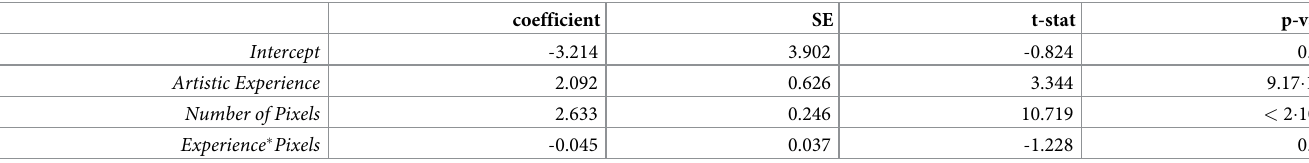
Table 2. Regression table for the regression in Eq